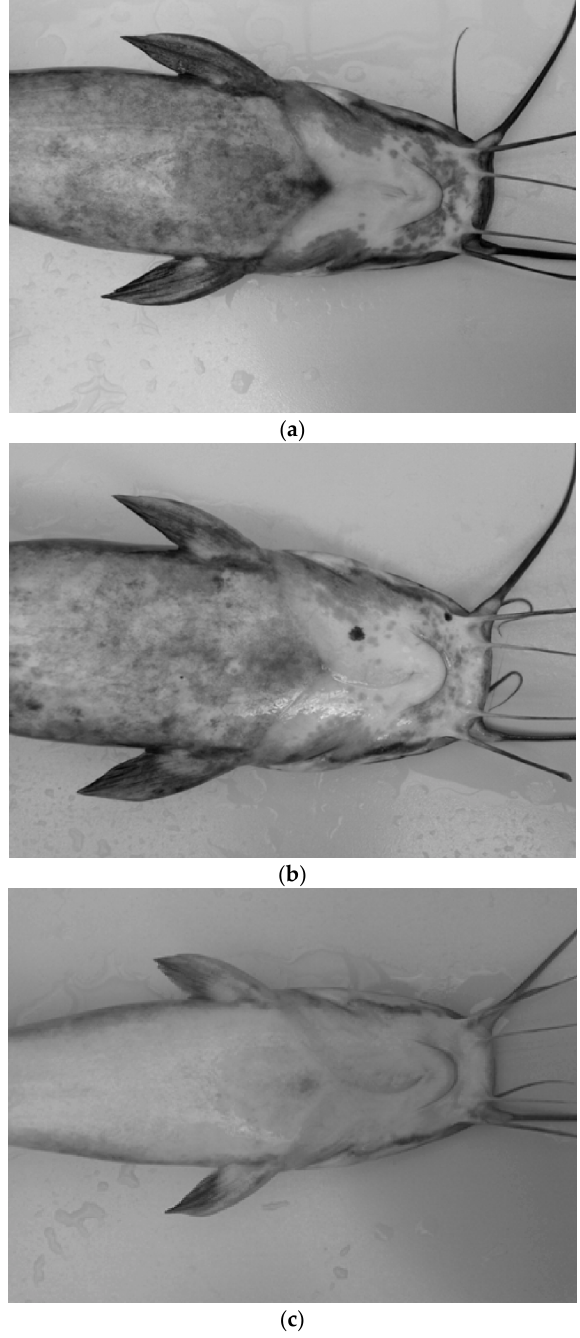
Figure 4. ( a – c ) Examples of individual differences in skin patterns of C. gariepinus . Each fish was placed in a recovery tank, and after regaining all reflexes, they were put back into their respective aquaria from which they were caught. In the meantime, blood samples were stored on ice and subsequently centrifuged (Hettich Universal 320 R, Tuttlingen, Germany) with 1500 g at 4 °C for 10 min to separate plasma and cells. The plasma was stored at − 80 °C, and cells were discarded. A sandwich-ELISA for fish cortisol (detection minimum: 0.0023 ng mL − 1 , Cusabio, MD, USA) was conducted with a microplate reader (BioTek Synergy HT, Winooski, VT, USA) at 450 nm to determine cortisol